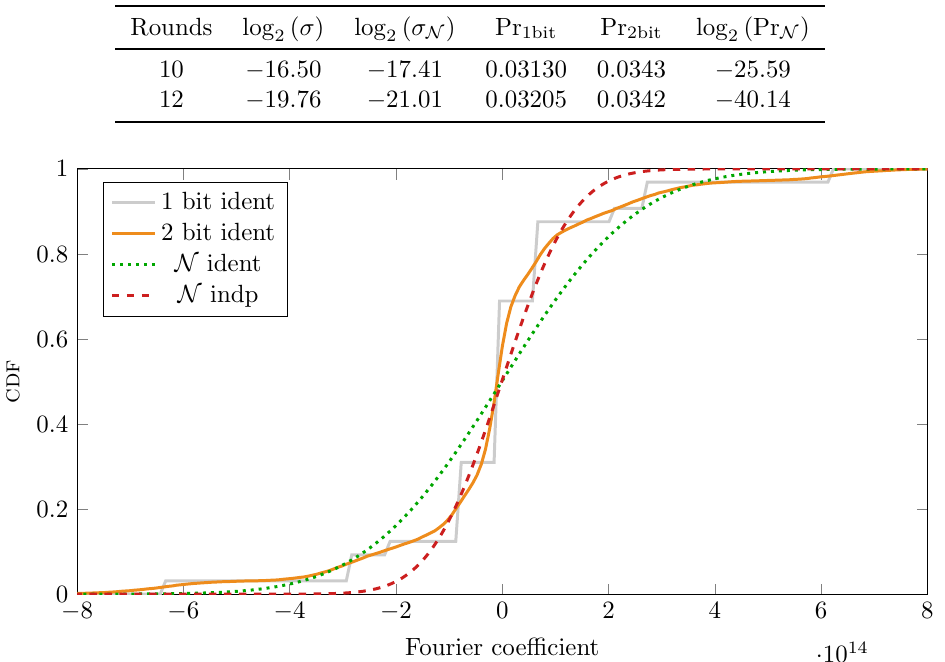
Table 2: Probability of outliers deviating more than 3 · σ , or Pr [ | X | > 3 · σ ], for one and two bit distributions. For X ∼ N (0 , σ ), Pr [ | X | > 3 · σ ] = 0 . 0027.